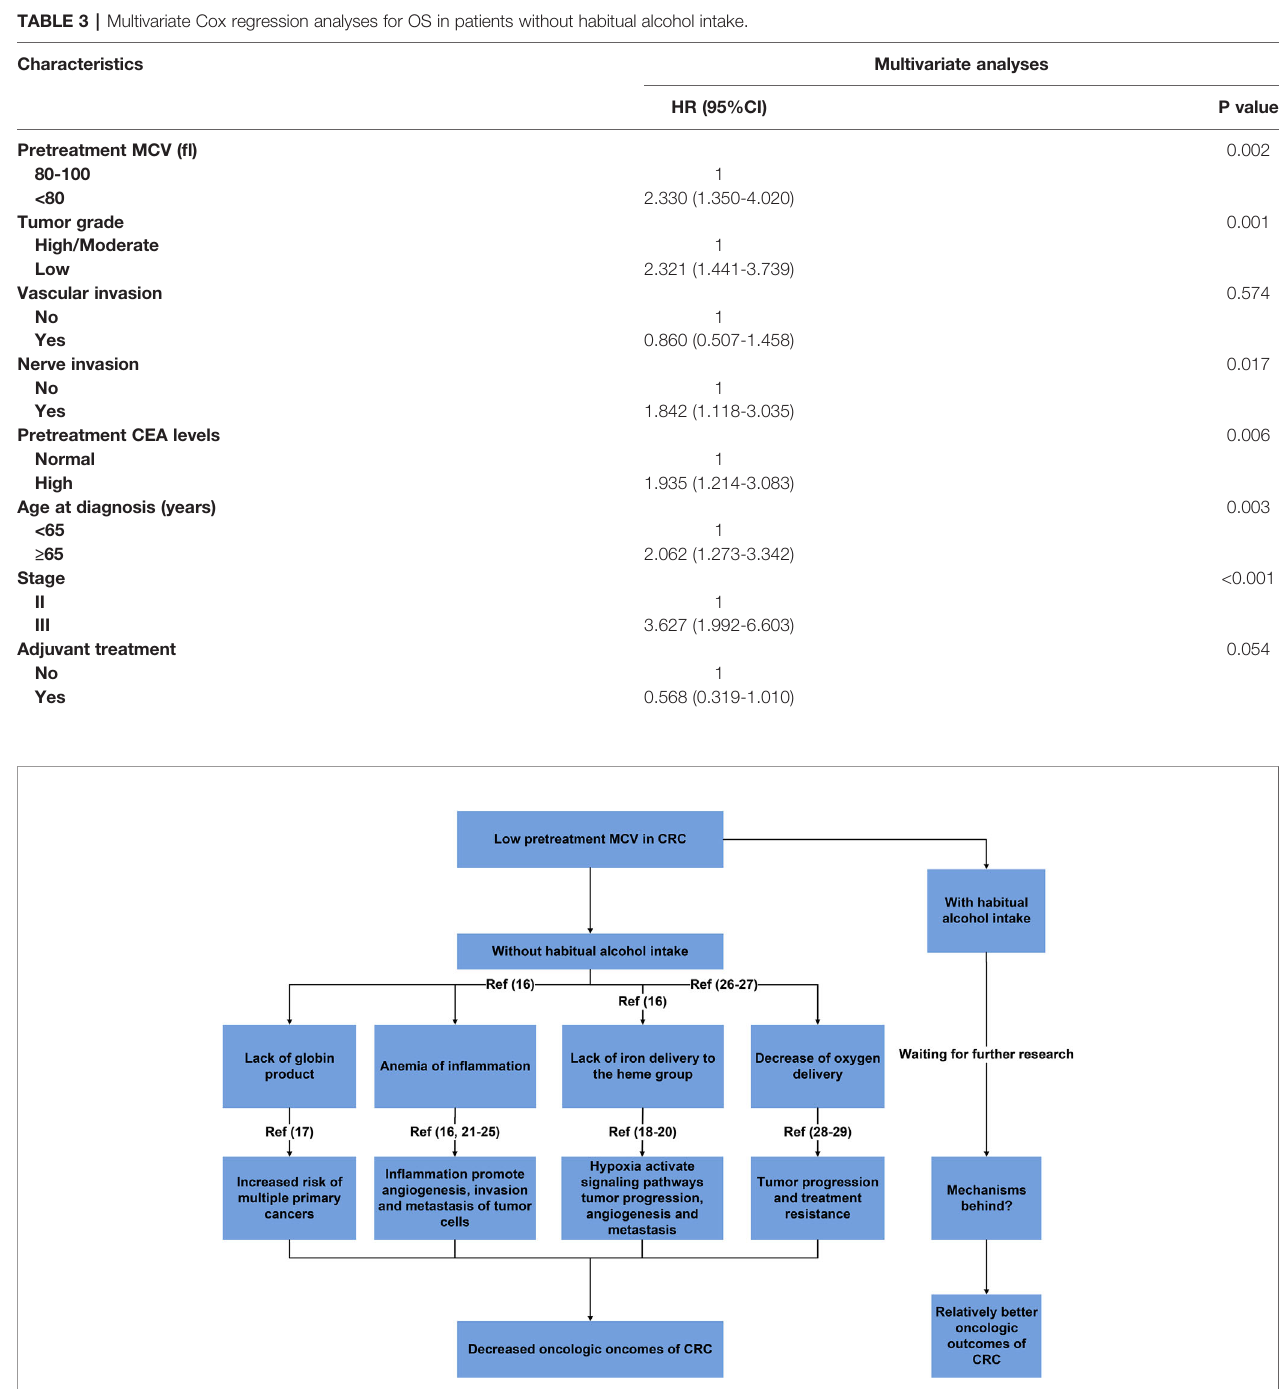
FIGURE 4 | Summary of reasonable mechanisms behind the prognostic role of MCV with the implications of habitual alcohol